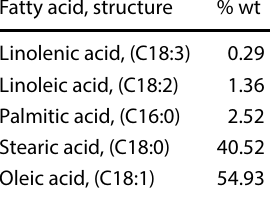
Table 1 The fatty acid composition of